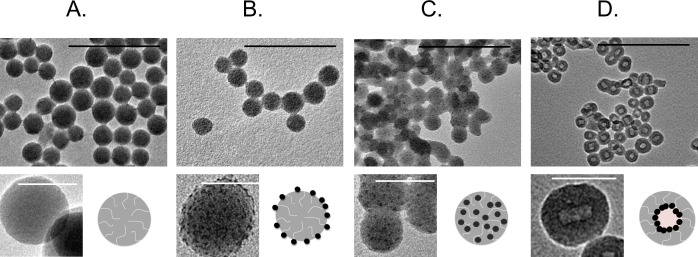
TEM images of typical (a.) metal-free SiO2, (b.) Ni-SiO2, (c.) nhNi@SiO2 and (d.) hNi@SiO2 samples. Scale bars are 200 nm for larger images (black) and 50 nm for smaller pictures (white).